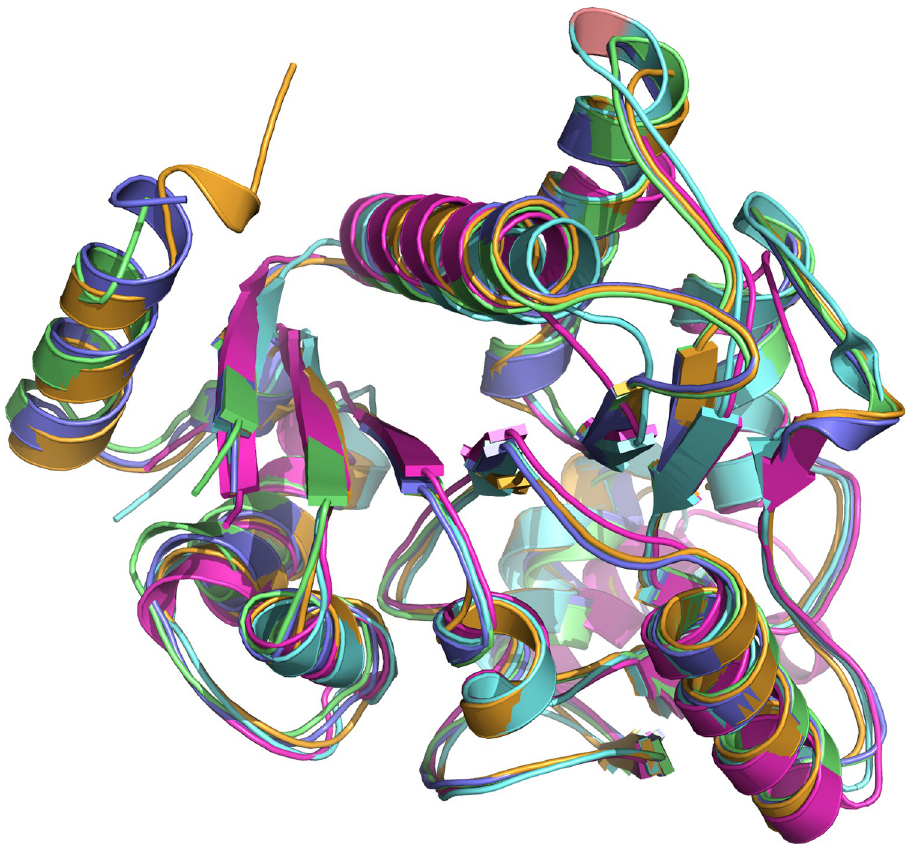
Fig 2. Overlay of deaminase monomers: Magenta- B . subtilis , cyan- S . mutans , orange- E . coli , violet- Hi and green: Pm . The presence of alpha-8 helix (in Pm , Hi and E . coli ) is seen on the top left.